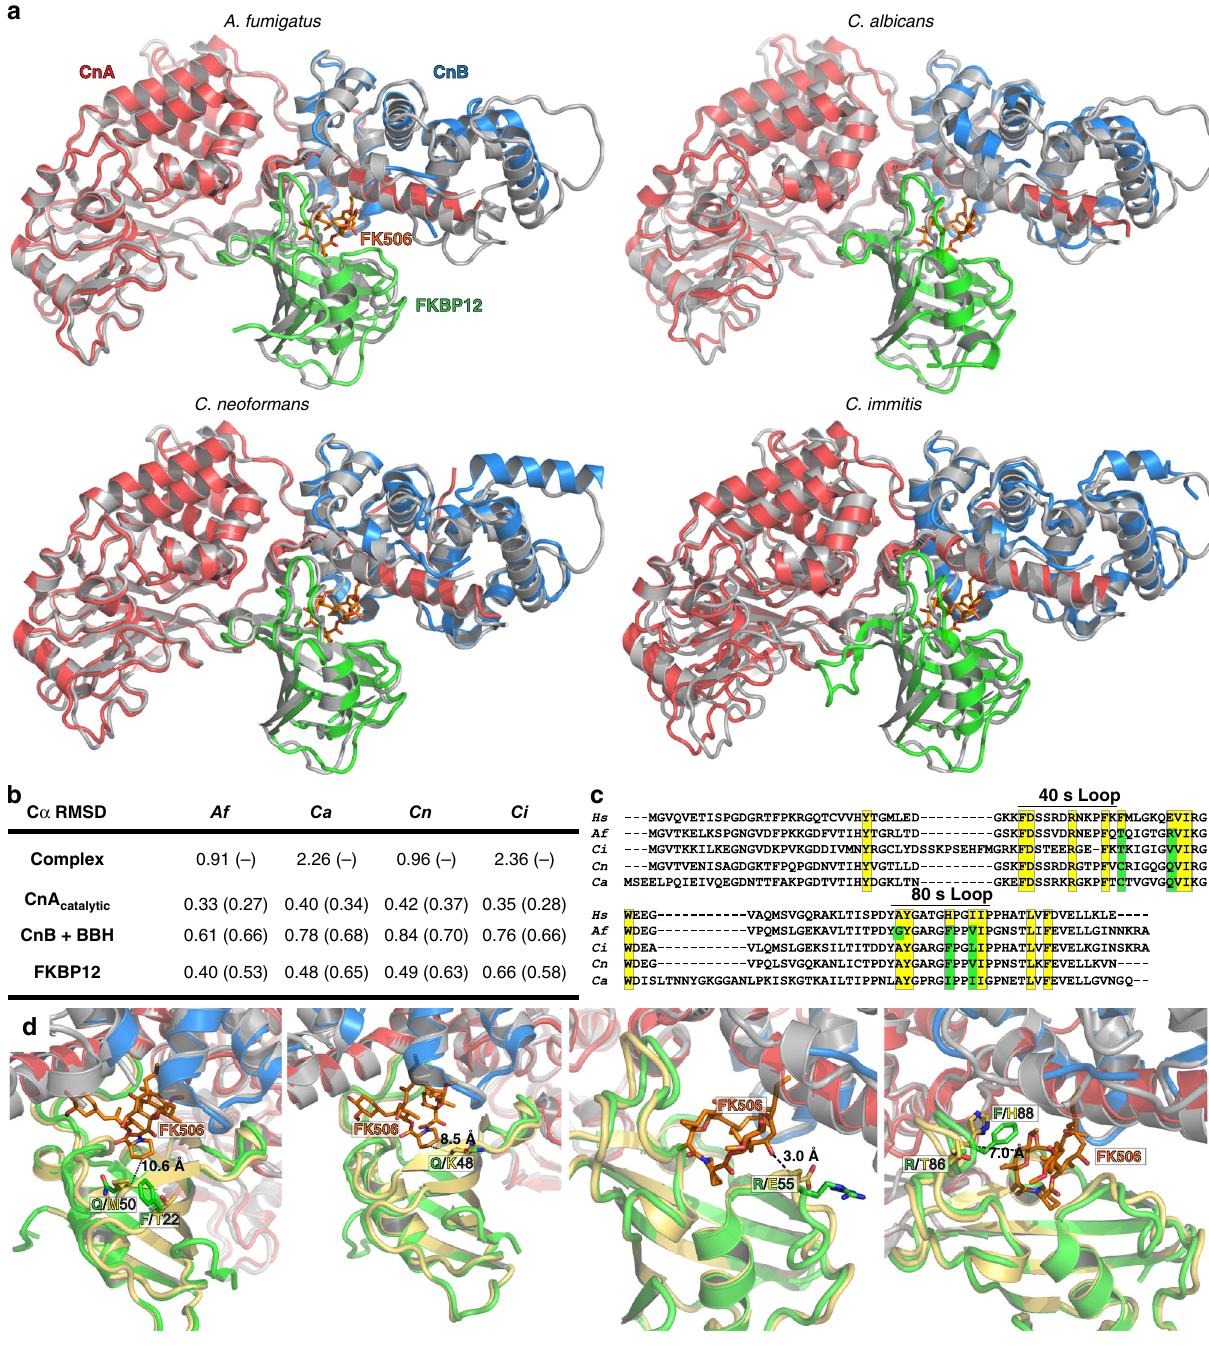
Fig. 1 Crystal structures of fungal CN – FK506-FKBP12 complexes. a Overlay of fungal CNs with the bovine complex (bovine: PDB 1TCO gray; fungal: CnA red, CnB blue, FKBP12 green and FK506 in orange). b RMSD of fungal CN complexes to the bovine complex and isolated components with Homo sapiens CN complex (CnA/CnB; PDB 4OR9) and H. sapiens FKBP12 (PDB 2PPN) in parentheses. c Alignment of human and fungal FKBP12s. Residues within 5 Å of FK506 are highlighted yellow. Non-conserved residues in fungi are highlighted green. d Structural comparison of variable residues in A. fumigatus (colored as in a ; PDB 6TZ7) and H. sapiens FKBP12 (colored yellow; PDB 2PPN). Note that both AfFKBP12 F22 and Q50 reside distal (>10 Å) to the FKBP12-FK506- binding site on CnA or CnB (panel 1). The side-chains of AfFKBP12 R55 and hFKBP12 E55 are near the BBH and CnB, but face away from FK506 and do not make conserved contacts to CnA/CnB other than a distal main-chain carbonyl interaction with FK506 (panel 3). See also Supplementary Fig. 1